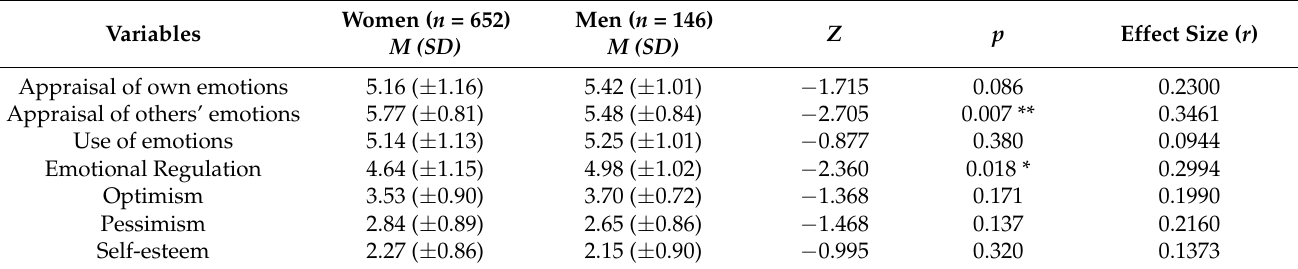
Table 3. Rank differences according to gender (U of Mann-Whitney